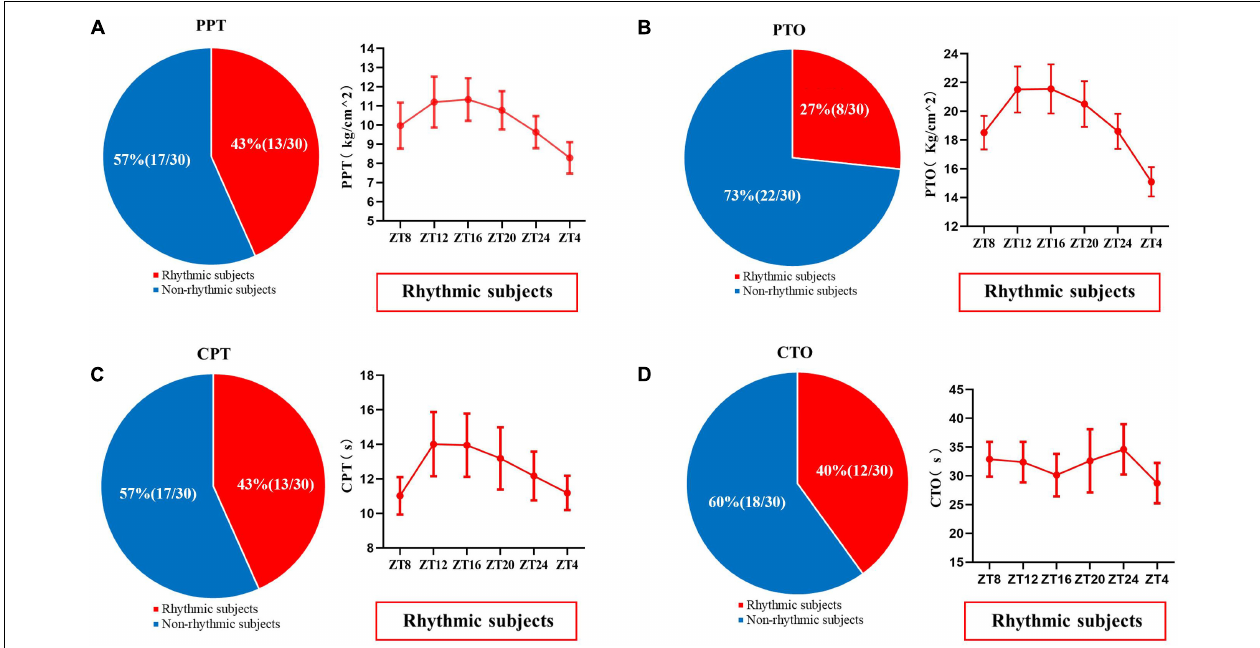
FIGURE 5 | The proportion of PPT (A) , PTO (B) , CPT (C) , and CTO (D) in subjects with or without significant periodic signal. Red shows the population with significant periodic signal, and blue shows the population without significant periodic signal. The change trend of the measured values with significant periodic signal is shown. Values are presented as mean ± standard error. PPT, pressure pain threshold; PTO, pressure pain tolerance; CPT, cold pain threshold; CTO, cold pain tolerance.